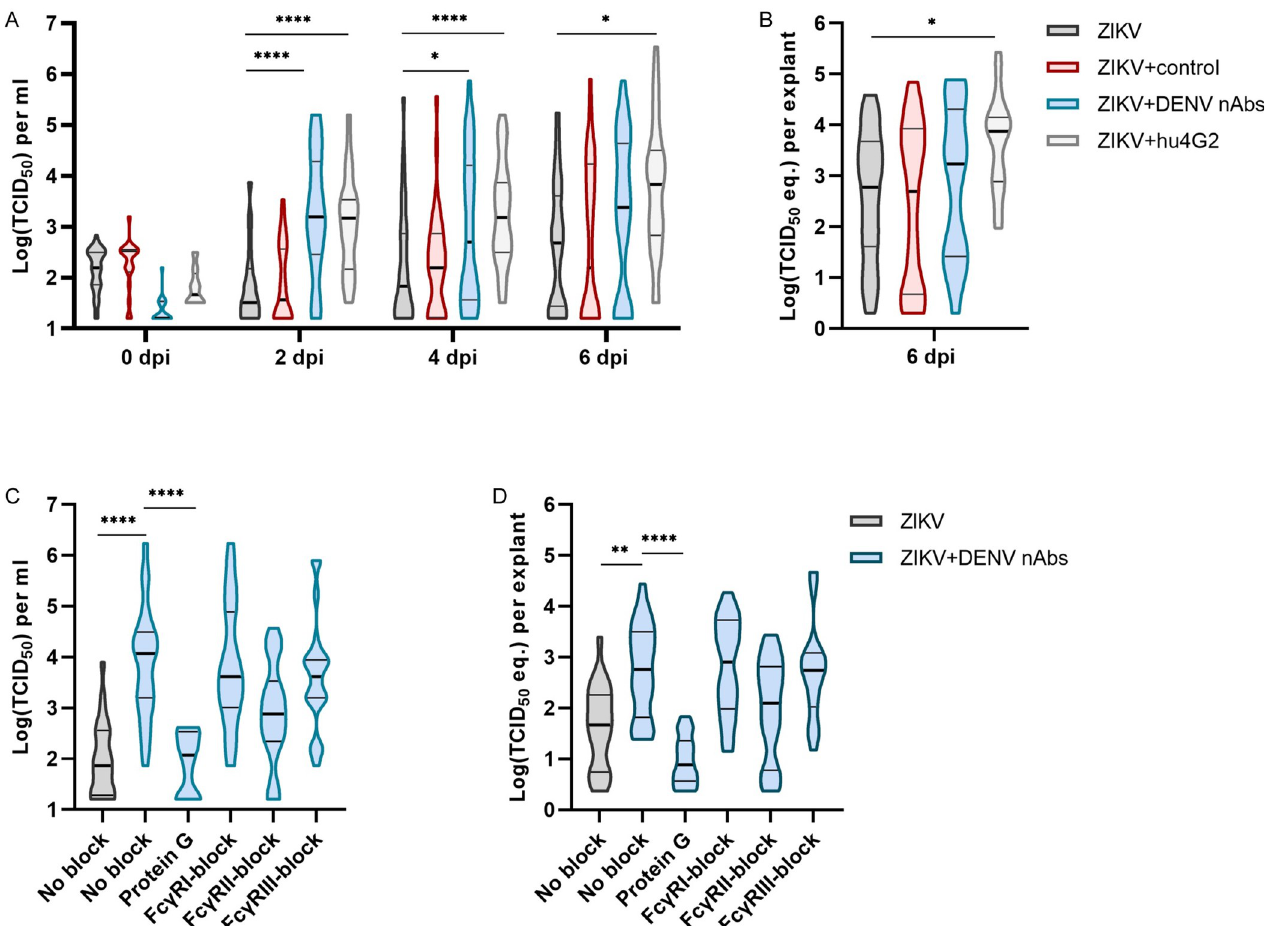
Fig 3. Cross-reactive flavivirus antibodies enhance ZIKV infection in placental explants. A&B : Term human placental explants were infected with 1.0x10 5 TCID 50 /mL ZIKV alone or ZIKV that was preincubated with flavivirus na ï ve serum (ZIKV+control) or serum containing DENV-2 neutralizing antibodies (ZIKV+DENV nAbs), both in a dilution of 1:250, or with a humanized panflavirus monoclonal antibody (hu4G2, 1 μ g/mL). ZIKV titers were determined in supernatants (A) and ZIKV RNA levels were determined with RT-PCR in tissue lysates (B) . C&D : Term human placental explants were pre-treated with FcyR blocking antibodies or protein G was added to ZIKV–DENV nAbs immune complexes. Subsequently, the explants were infected with either 1.0x10 5 TCID 50 / mL ZIKV or ZIKV+DENV nAbs. ZIKV titers were determined in supernatants at two dpi (C) and ZIKV RNA levels were determined in tissue lysates with RT-PCR at two dpi (D) . N = 3–4 donors per condition, on average 12 explants per donor. Horizontal lines in the violin plots represent median and the 10 th and 90 th percentile cut-off. Statistical significance was determined using the Kruskal-Wallis test followed by Dunn’s post hoc test. � P < 0.05, �� P < 0.01, ���� P < 0.0001.